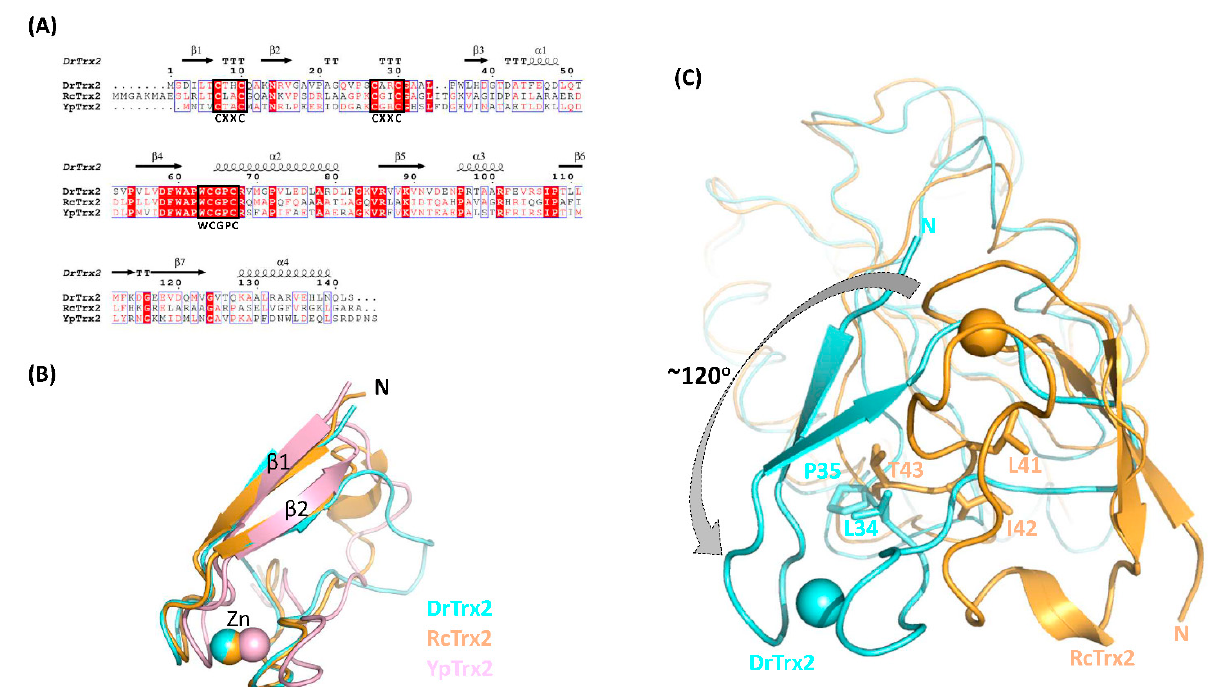
Figure 6. Structural comparison of DrTrx2 with other Trx2 proteins. ( A ) The structure-based sequence alignment of DrTrx2 with RcTrx2 and YpTrx2. The programs, Multalign (http://multalin.toulouse.inra.fr, accessed on 6 March 2021) and Espript (http://espript.ibcp.fr (accessed on 6 March 2021)), were used to visualize the alignment. White letters on red shading represent 100% identity. ( B ) Superimposition of the structures of the N-terminal zinc-finger domains from DrTrx2 (cyan), RcTrx2 (orange), and YpTrx2 (pink). The bound zinc ion for each protein is shown as a sphere. ( C ) Superimposition of the overall structures of DrTrx2 (cyan) and RcTrx2 (orange). For clarity, only DrTrx2 and RcTrx2 structures are shown. The C-terminal Trx-fold domains are shown as a ribbon diagram and the N-terminal zinc-finger domains are represented in cartoon. Lys43 and Pro35 from DrTrx2 and Leu41, Ile42, and Thr43 from RcTrx2 are shown in sticks. The bound zinc ion for each protein is shown as a sphere, and the difference between the domain orientations of two proteins is marked with an arrow.